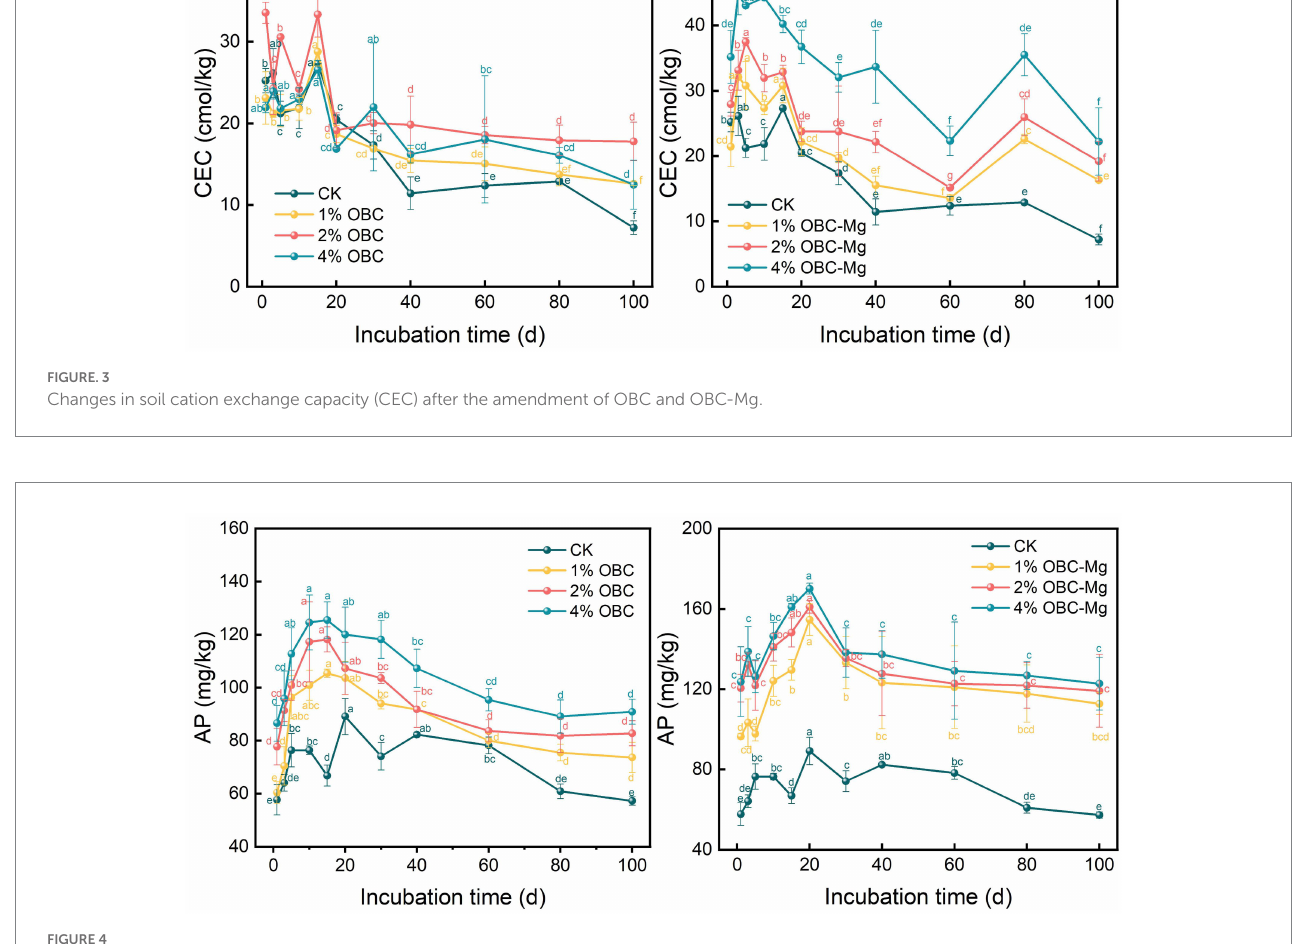
FIGURE 4 Changes in soil available phosphorus (AP) after the amendment of OBC and